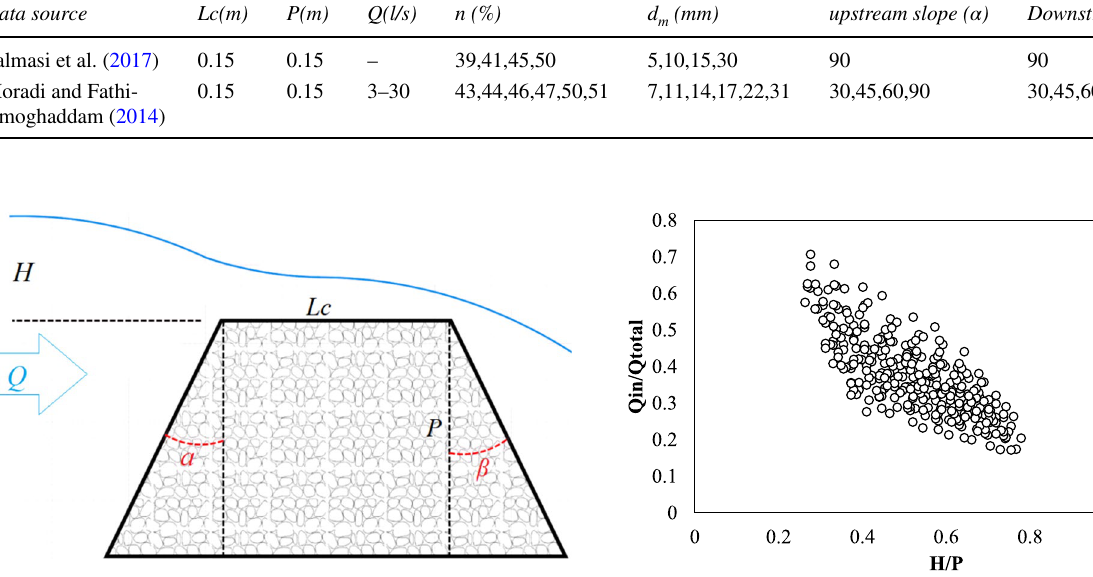
Fig. 3 Calculated through-flow discharge